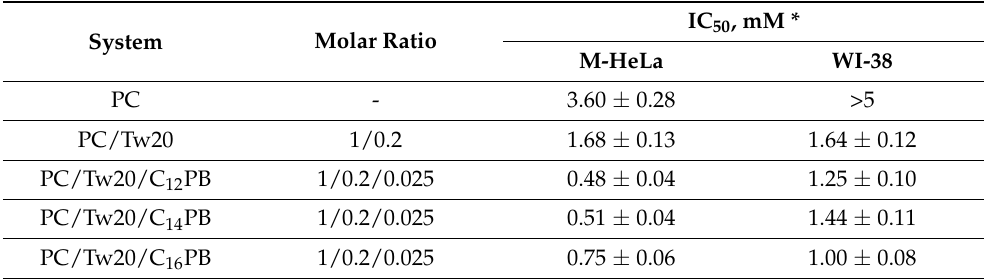
Table 3. The cytotoxic effect of transfersomes, loaded with 2-PAM, toward normal (WI-38) and cancer (M-HeLa) human cell